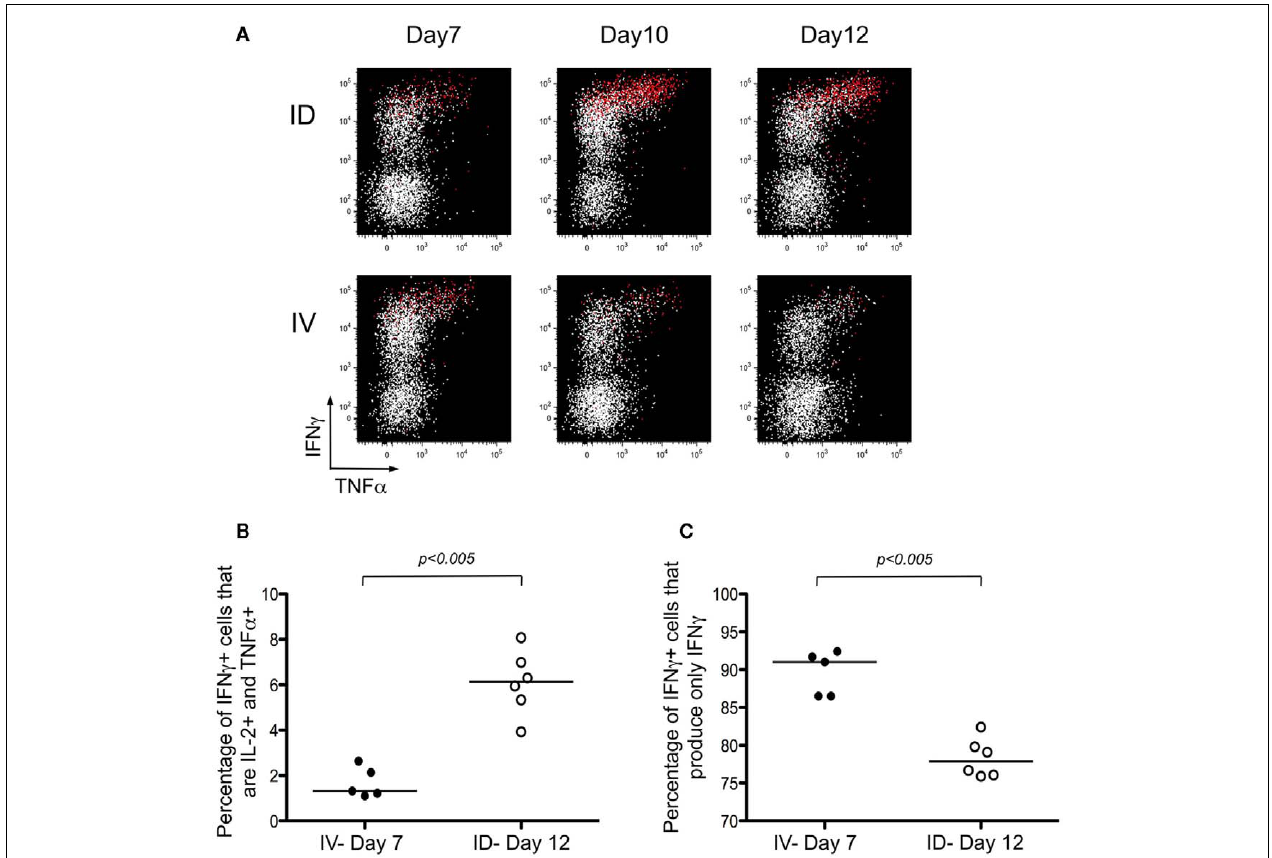
surface and intracellular staining. (A) Data from live, CD3 + , CD8 + T cells are shown. Cells producing IL-2 are highlighted in red.The percentages of IFN γ + cells that produce either the three cytokines – IFN γ , IL-2, andTNF α (B) or only one cytokine – IFN γ (C) were calculated. p -values were calculated using a Mann–Whitney